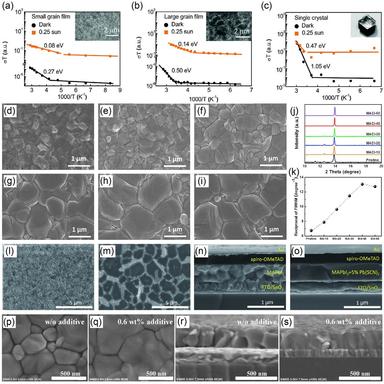
Temperature-dependent conductivity of a small-grain film (a), large-grain film (b), and a single crystal (c). Copyright 2016, Royal Society of Chemistry. Top-view SEM images (d–i) and XRD spectra (j) of perovskite films prepared with different amounts of MACl. (k) Reciprocal FWHM obtained from (j) at the diffraction peak 13.9. Copyright 2019, Elsevier Inc. Top-view (l and m) and cross-sectional (n and o) SEM images of MAPbI3 films without (l and n) and with 5% Pb(SCN)2 (m and o)